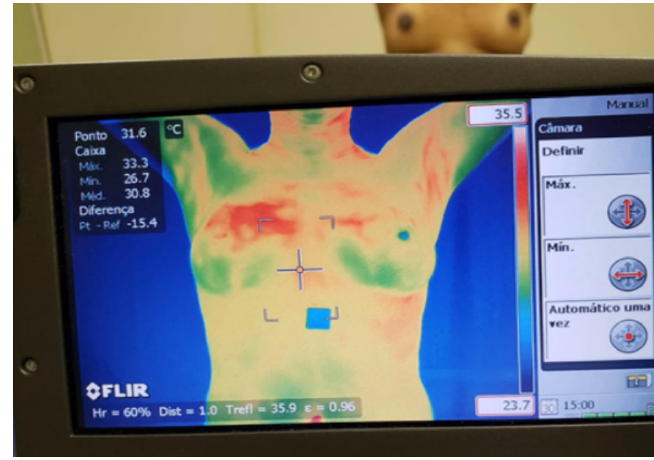
Figure 1. Thermogram acquisition from volunteer